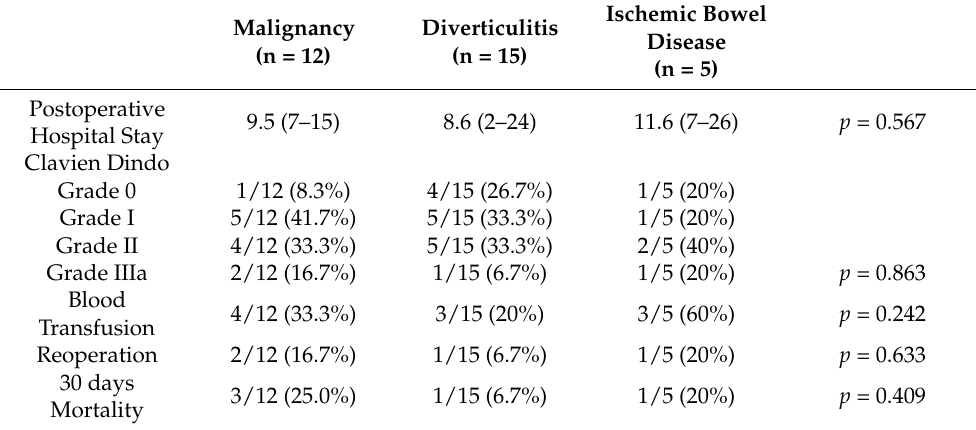
Table 3. Postsurgical data in different colon diseases. Significance tests used are ANOVA and Chi-Square. Malignancy